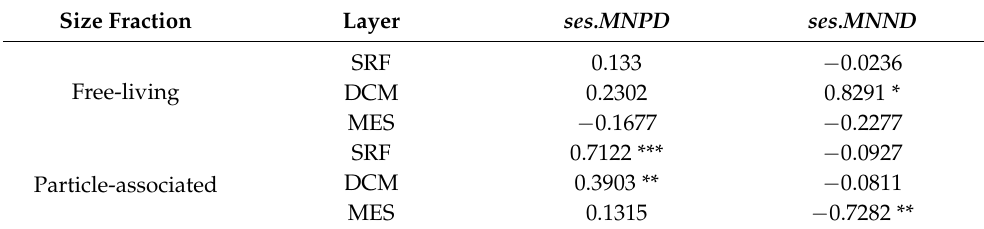
Table 1. The influences of ses.MNPD and ses.MNND on node connectivity were analyzed by the generalized linear model. SRF: surface water layer; DCM: deep chlorophyll maximum layer; MES: mesopelagic zone. Size Fraction Layer ses.MNPD ses.MNND SRF 0.133 − 0.0236 Free-living DCM 0.2302 0.8291 * MES − 0.1677 −